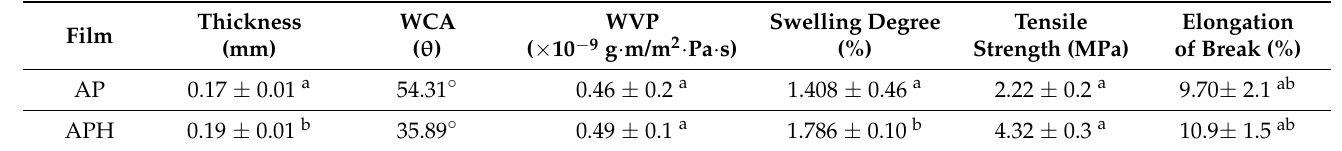
Table 2. Thickness, WCA, WVP, and swelling ratio of AP and APH